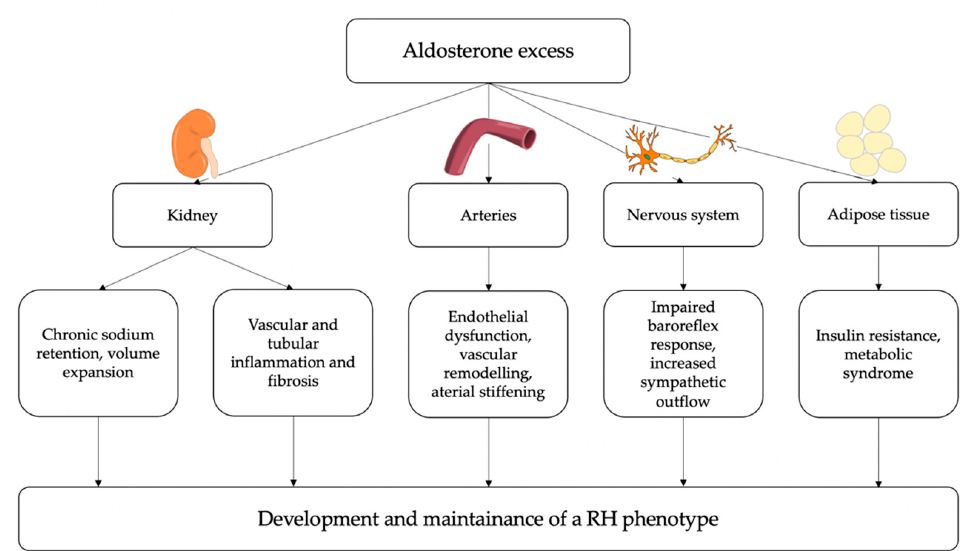
Figure 3. Potential pathophysiological mechanisms linking aldosterone excess and resistant hyper- tension (RH). At a renal level, aldosterone induces chronic sodium and water retention, leading to intravascular volume expansion; moreover, aldosterone can contribute to vascular and tubular inflammation and fibrosis, thereby impairing kidney function. At a vascular level, aldosterone in- duces endothelial dysfunction, oxidative stress, inflammation and fibrosis thereby leading to arterial stiffening. Additionally, aldosterone excess can directly influence sympathetic activity and can also have a role in the development of insulin resistance and metabolic syndrome. Eventually, these detrimental effects of aldosterone excess on several target tissues can contribute to the development and maintenance of resistant